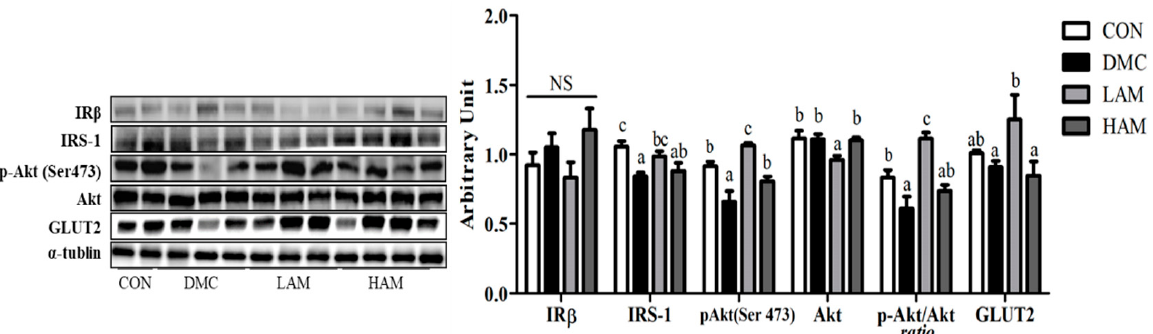
Figure 6. Effect of AME on insulin signaling in T2DM mice All values are reported as mean and SEM. Values with the different superscript letter were significantly different ( p < 0.05; ANOVA with post-hoc Duncan’s multiple range test). n = 6 mice in each group CON, normal control group (negative control); DMC, type 2 diabetic control group (positive control); LAM, diabetic group supplemented with low dosage (50 mg/kg BW) of AME; HAM, diabetic group supplemented with high dosage (100 mg/kg BW) of AME.